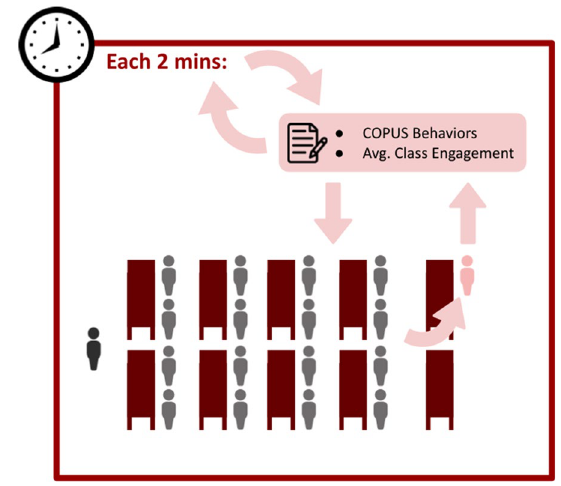
Fig. 1 Schematic representation of our data collection procedure. An observer sat discretely behind the class so that the data collection process was not disruptive, and at the same time all of the students were assessed while performing the observations. At each 2 min of the lesson, the observer estimated, via an observation form, which COPUS behaviors were present, as well as what level of engagement the class